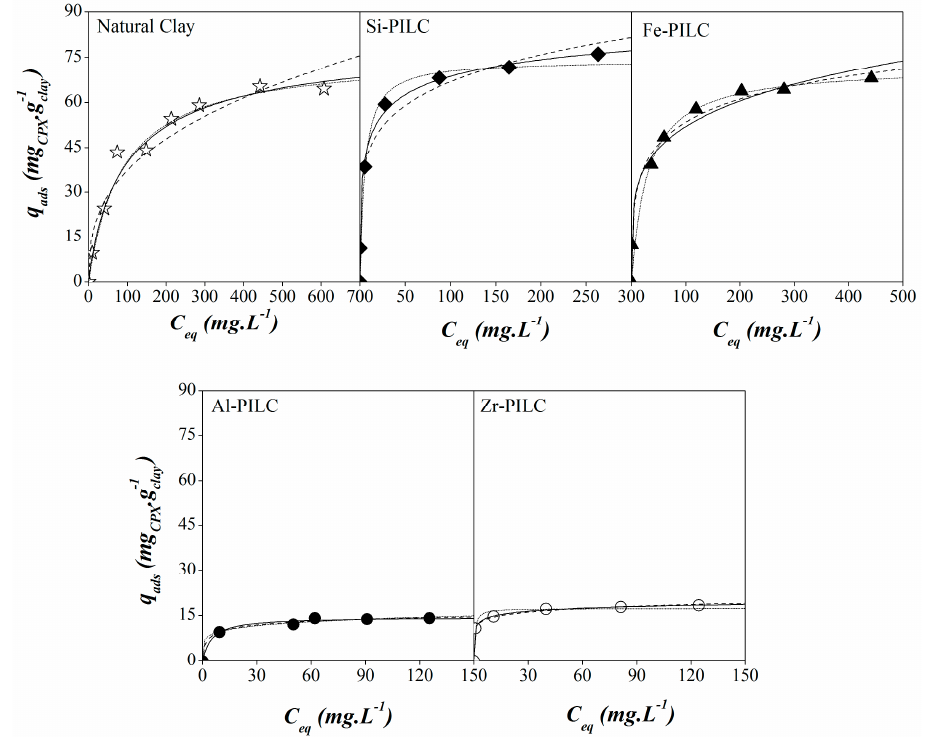
Figure 5. Experimental isotherms (symbols) and Langmuir (dash), Freundlich (dot) and Sips (straight) adjustments for the equilibrium adsorption data of CPX on natural clay (NC) and pillared clays (PILC).